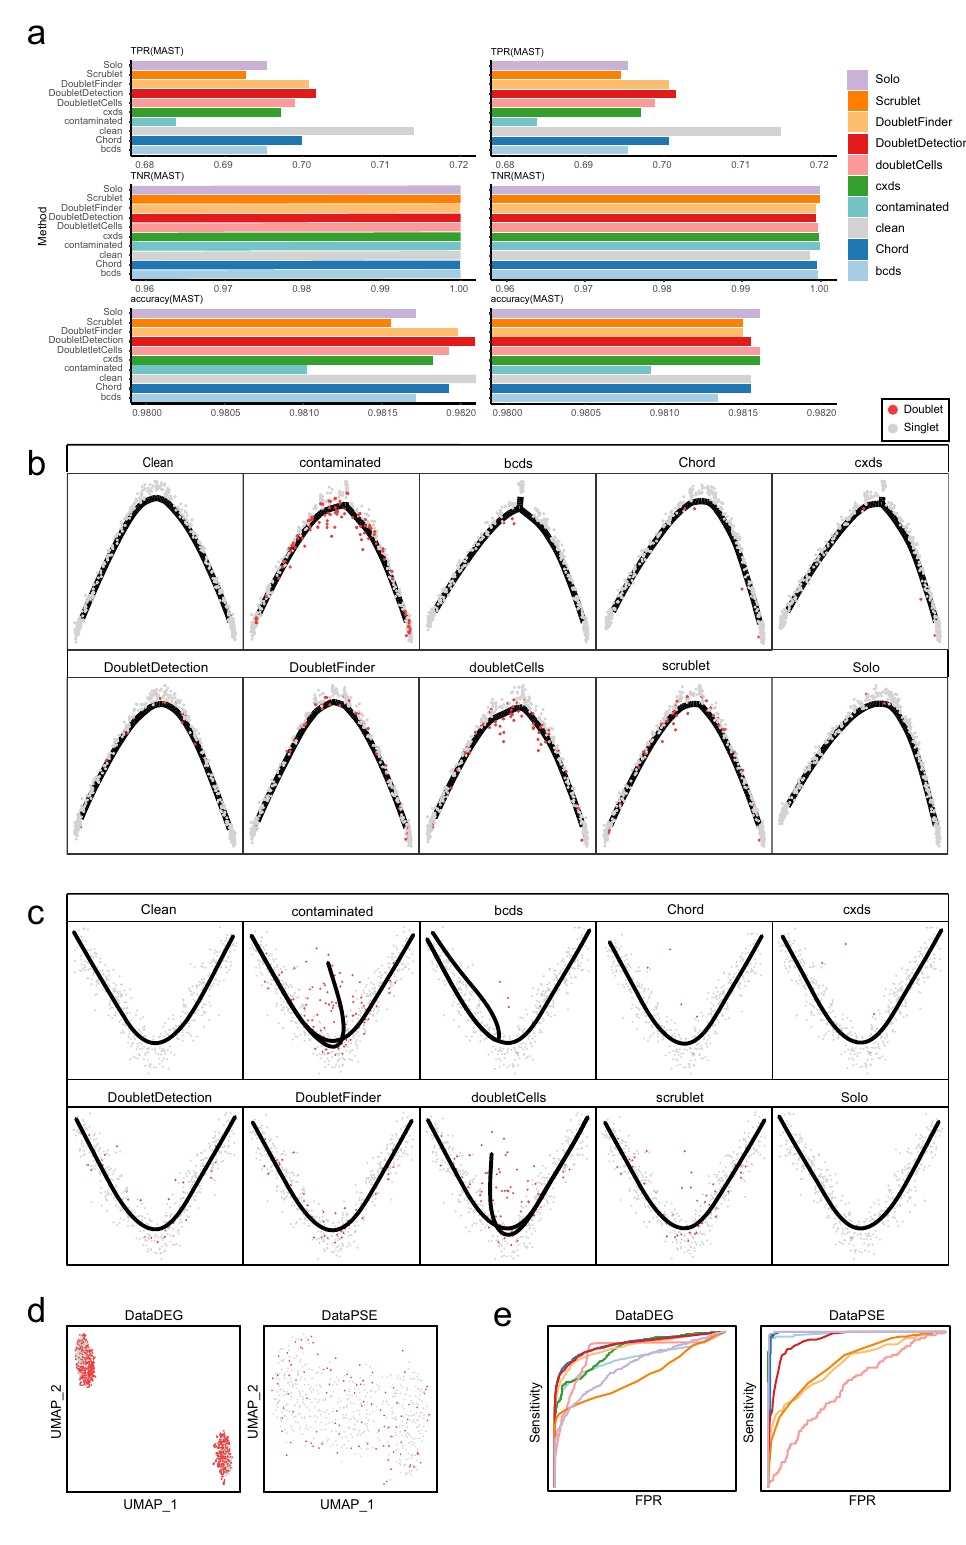
Methods Chord overview . Data input. The input format used in Chord was a comma- separated expression matrix, which was a background- fi ltered, UMI-based count matrix for a single sample. Chord pre-processes the count expression matrix according to the Seurat analysis pipeline. Chord can also directly accept object fi les generated by the Seurat analysis pipeline. In addition, it is suggested that users estimate a doublet rate (Supplementary Fig. 1) based on the loading conditions so that Chord can simulate a simulated training set that is similar to the real dataset